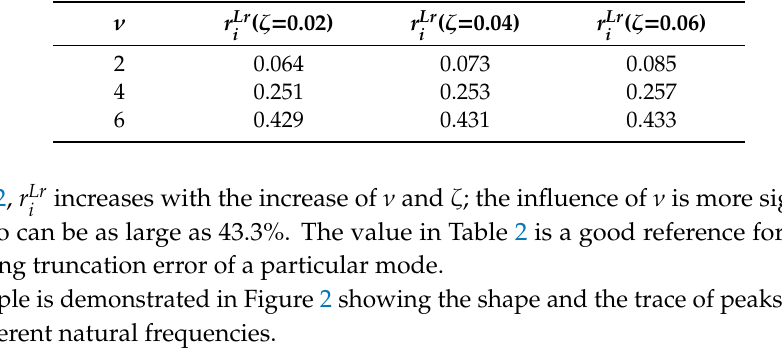
Table 2. Error ratio r Lr